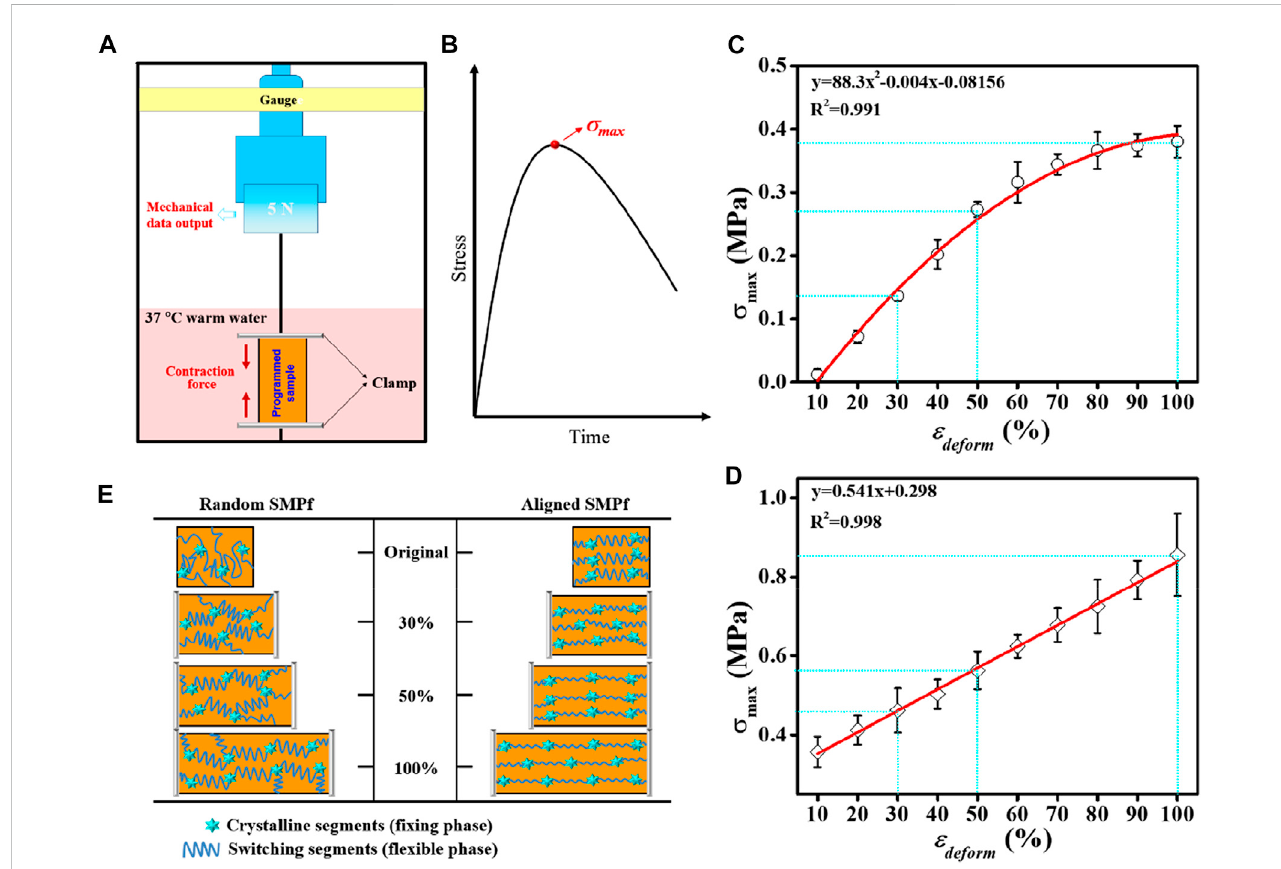
FIGURE 5 Comparative study on the shape recovery stress σ rec regulated by the deforming strain ε deform between random fi bers and aligned fi bers. (A) Schematic representation of the test device for σ rec measurements. (B) Schematic representation of the stress − time curve from the constrained recovery test in (A) , with the peak stress indicating σ max . (C, D) Relationships of the maximum recovery stress ( σ max ) versus ε deform determined from (A) for random (C) and aligned (D) , respectively. (E) Proposed mechanism of PLLA – PHBV shape-memory fi bers using a stretch deforming process with the varied ε deform (30%, 50%, and